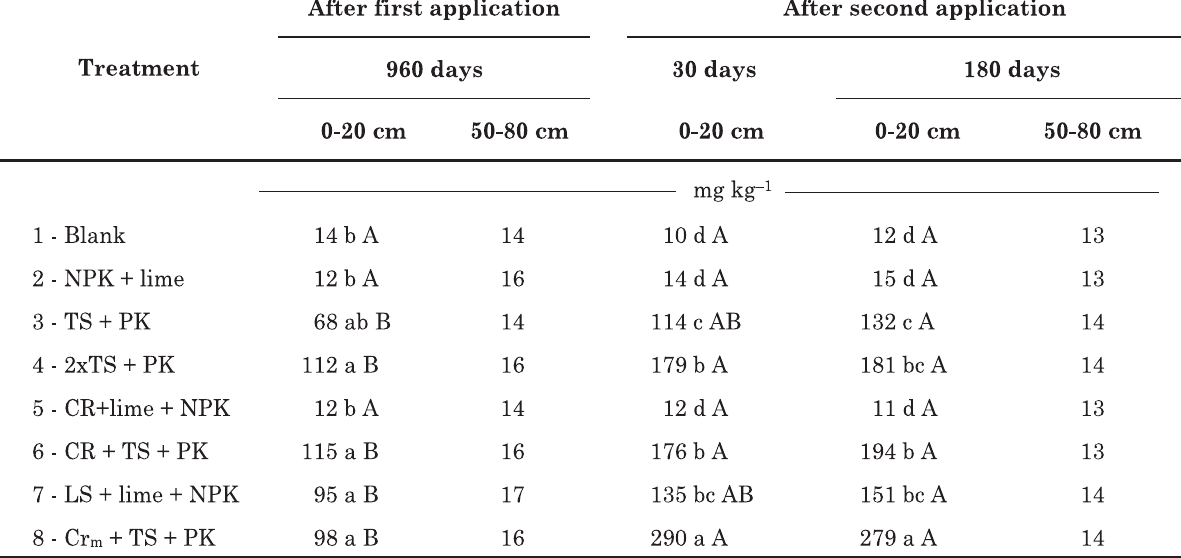
Table 4. Chromium contents (1) of the surface soil layer (0-20 cm) at three sampling times (one after the first residue application and two after the second) and of the subsurface layer (50-80 cm depth) at two sampling times